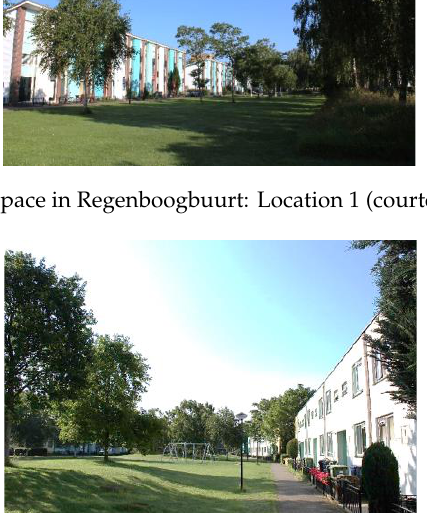
Figure 6. Green space in Regenboogbuurt: Location 2 (courtesy of Author 2).